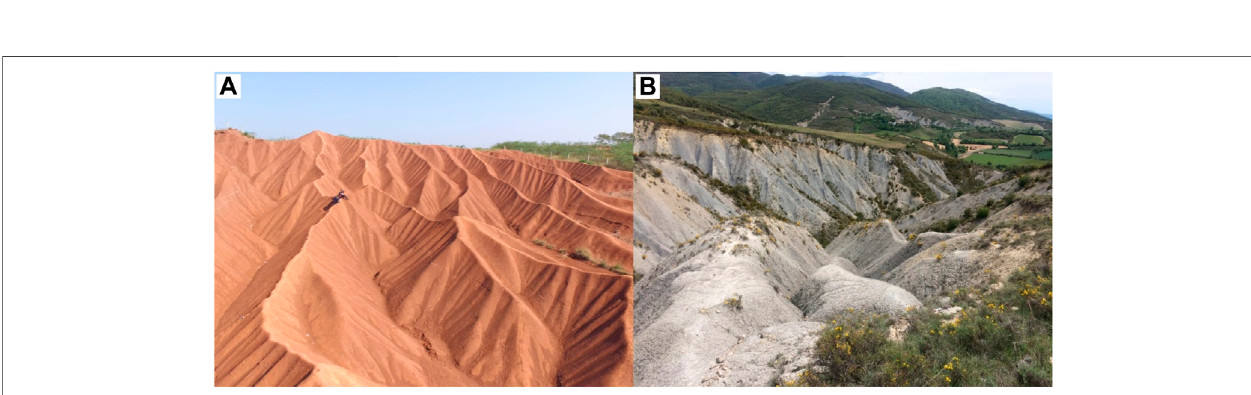
Frontiers in Earth Science |